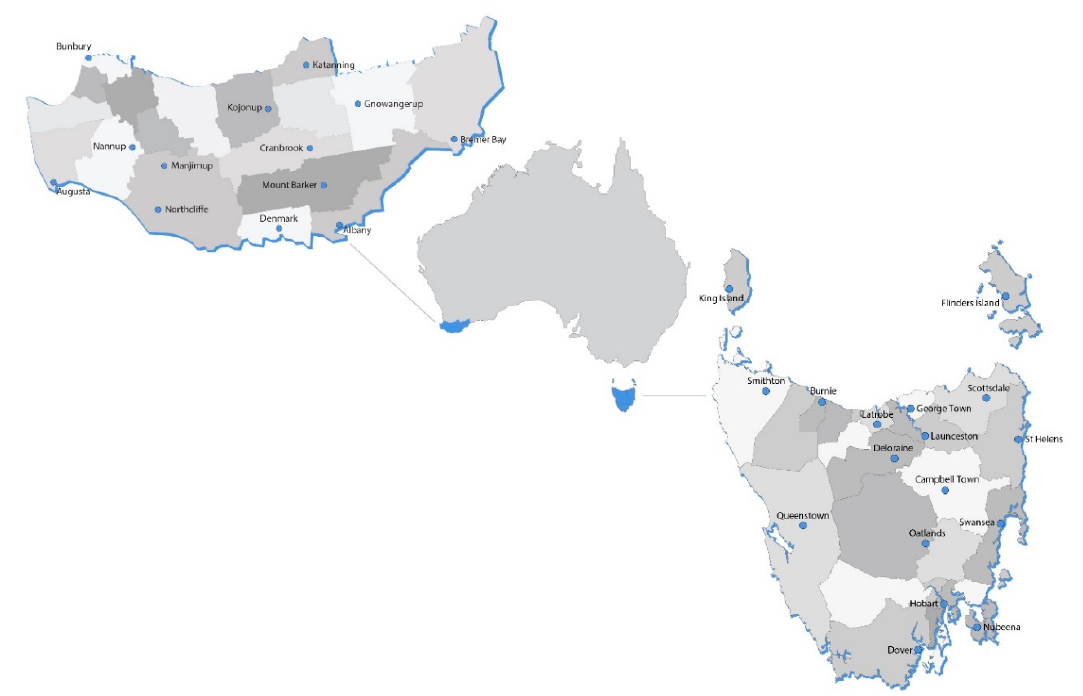
Figure 1. Geographical location of Tasmania and South Western Australia regions of Australia.